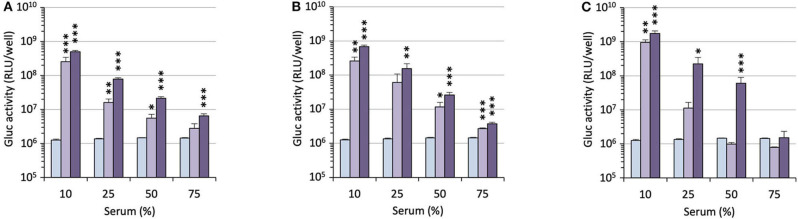
Transfection efficiency of pro-APLs ME12
(A), PE12
(B), and EE12
(C) as a function of serum content. Pro-APL/DNA complexes were prepared at N/P 3, with 1 molar eq. of DOPE. A549 cells (6,000 cells/well) were seeded into 96-well plates in 100 μL of culture medium containing 10% serum. Twenty-four hours later, cell supernatant was replaced with culture medium complemented with increasing amounts of serum (from 10 to 75%) just before adding the lipoplexes (0.2 and 0.4 μg of DNA per well; light and deep purple bars, resp.). Control (light blue bar) refers to basal bioluminescence measured in untreated cells. Data for EE12 are reported from our previous work (Gaillard et al., 2019). Statistical significance vs. control. ***p < 0.001, **p < 0.01, *p < 0.05.